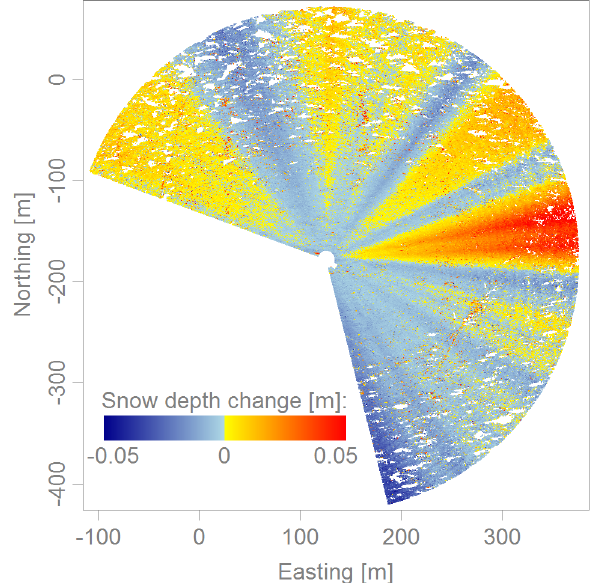
Figure 2. Difference between the scans acquired on 6 and 11 Jan- uary 2017. Patterns in the shape of sectors with a magnitude of up to 10cm are visible. These patterns are caused by small inclination changes of the